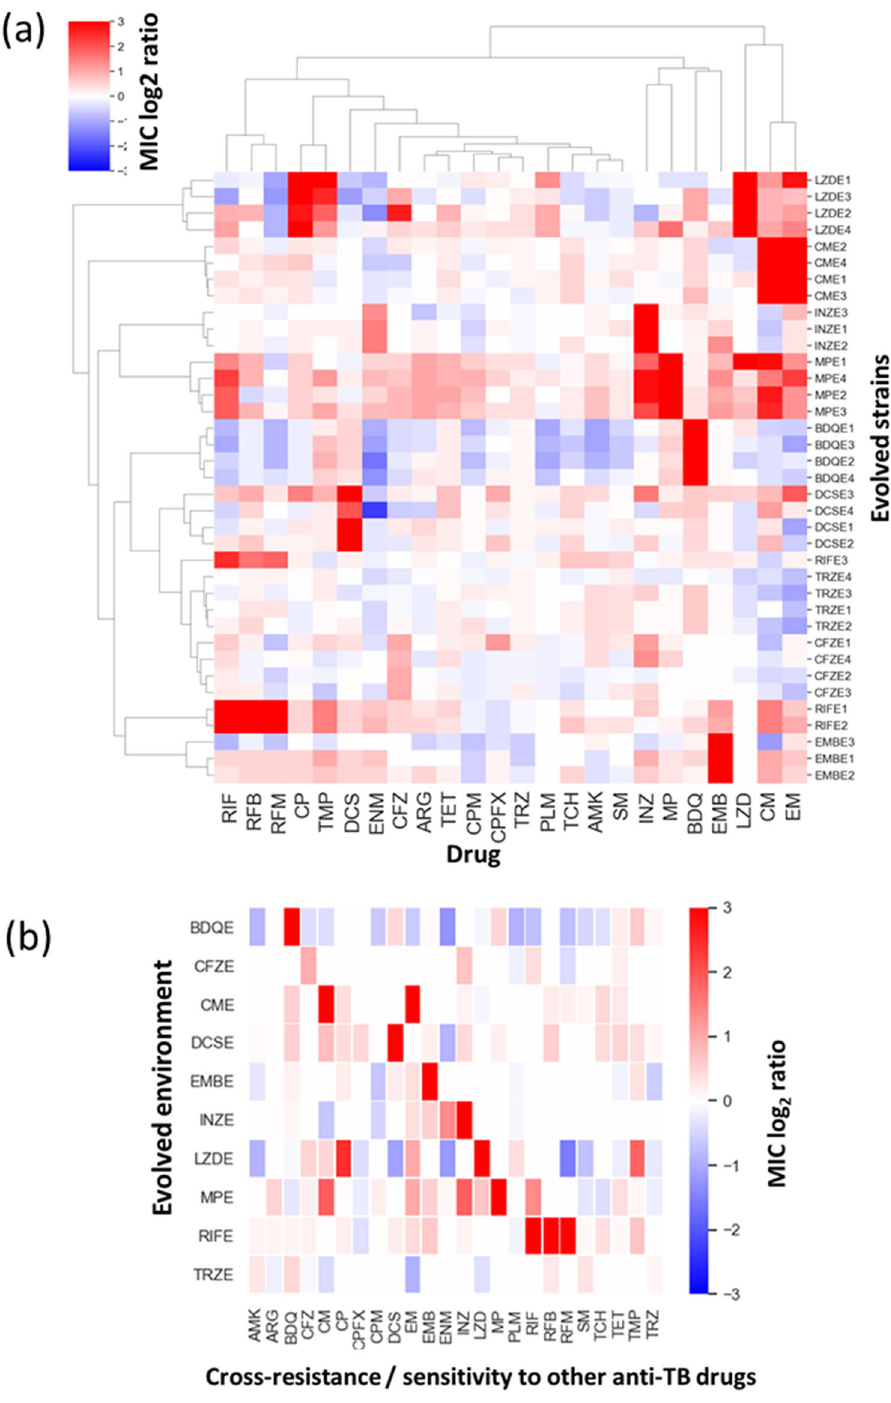
Figure 3. Consequence of anti-tuberculosis (TB) drug resistance evolution: cross-resis and collateral sensitivity. ( a ) Heatmap representing the quantification of anti-TB drug susceptibilities in the 37 evolved strains. The color coding represents the increase (red) or decrease (blue) in minimum inhibitory concentrations (MICs) relative to that in the wild-type (NCTC8159) strain. For each strain, the MICs for three replicates of the evolved strains and twenty replicates of the wild-type strains were calculated. The order of anti-TB drugs and evolved strains was determined by hierarchical clustering using the function seaborn.clustermap in Seaborn library of Python 3.7. ( b ) The identified combinations of drugs that exhibited either cross-resistance or collateral sensitivity for each evolved strain in the same environment. The combinations were determined using the Mann–Whitney U test (FDR < 0.05), and the colors indicate resistance to the stress relative to the parent strain. The heatmap was generated using the function seaborn.heatmap in Seaborn library of Python